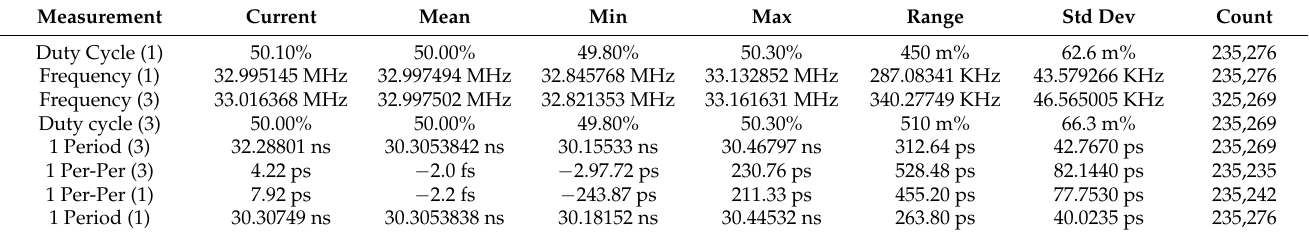
Table 3. Summary of duty-cycle and frequency measurements for channel 1 (point 1) and channel 2 (point 3). Measurement